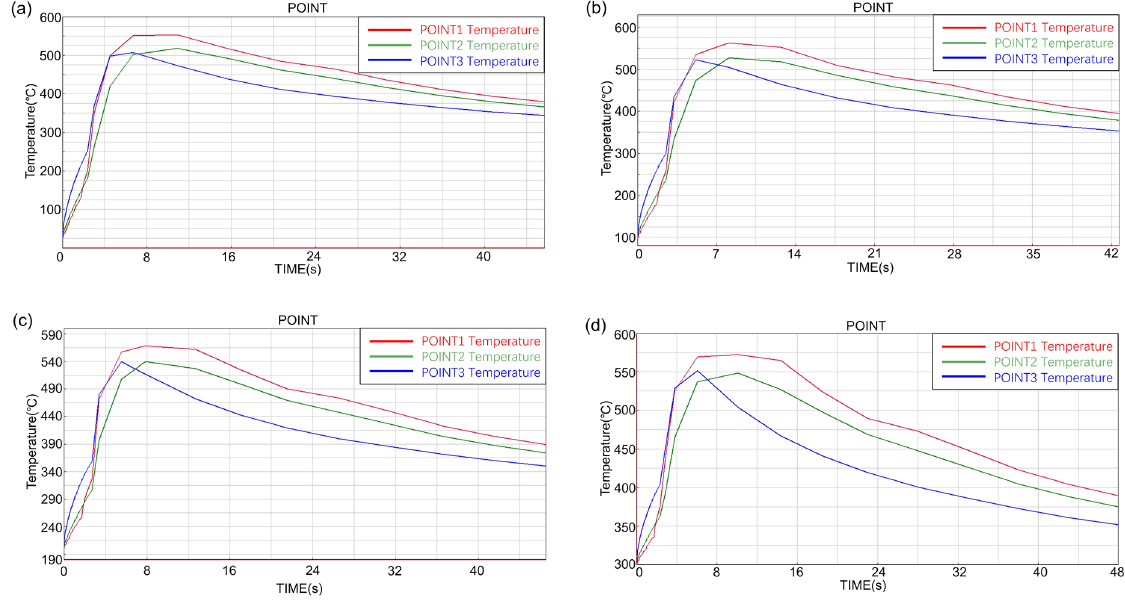
Figure 11. The temperature–time curve of the inner surface of short ring at different preheating temperatures: ( a ) 25 °C, ( b ) 100 °C, ( c ) 200 °C and ( d ) 300 °C.